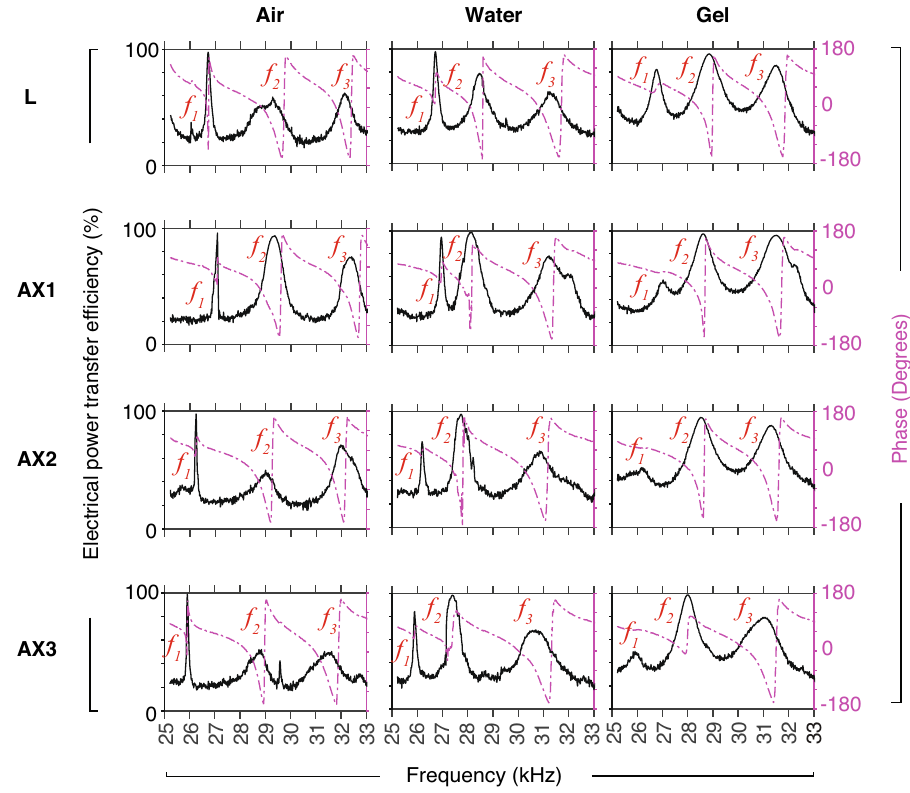
Figure 10. Typical recorded magnitudes of the instantaneous power transfer efficiency (PTE) obtained using swept-sine excitation, for the lancet (L) and axi-symmetric bevels AX1–3, in air, water, and and gelatin, at depth of 20 mm. One-sided spectra are shown. Measured FRFs (sampling frequency 300 kHz) were low-pass filtered, then downsampled by a factor of 200, for the purpose of modal analysis. The signal-to-noise ratio was Phase (dashed purple line) of PTE is shown in degrees ( ◦